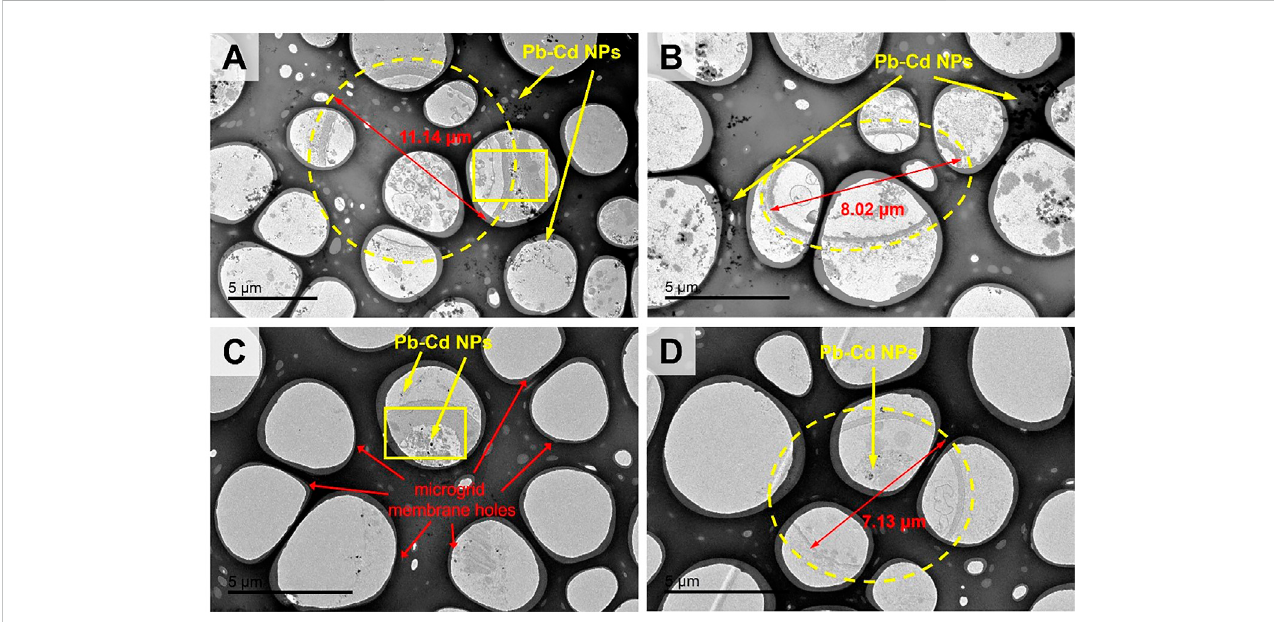
The TEM images of morphological changes of Aspergillus niger after 5 days incubation in the TPbCd treatment. Cell diameters of several representative cells were shown. Representative Pb and Cd nano-particles (NPs) were shown.